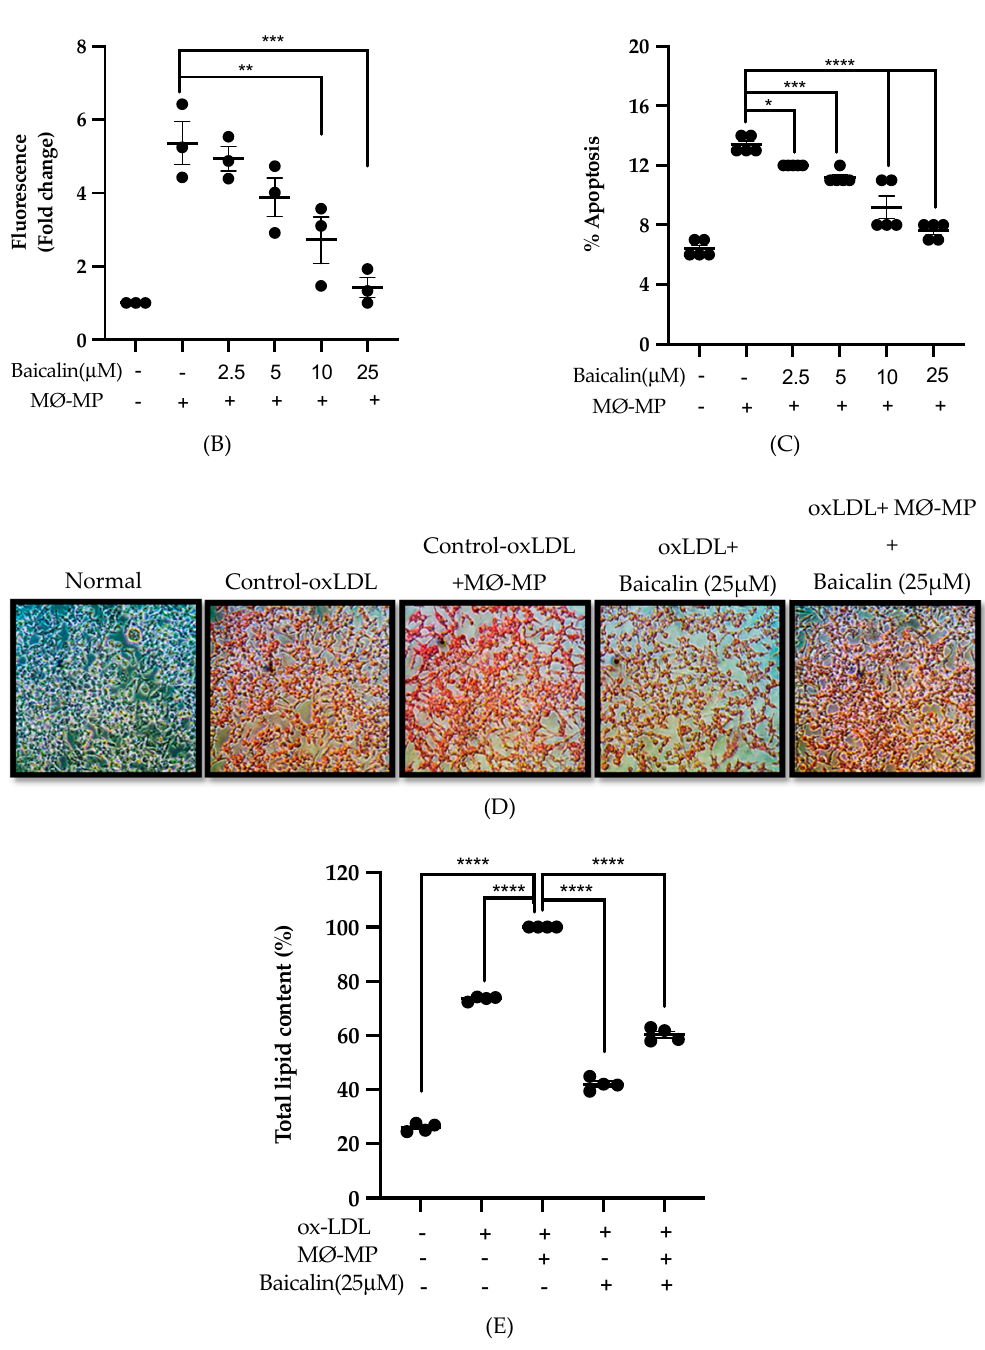
Figure 3. Effect of baicalin on MØ-MP induced reactive oxygen species (ROS) production, apoptosis, and foam cell formation in RAW264.7. ( A ) RAW264.7 cell was treated with or without MØ-MP and a various dose of baicalin for 24 h. DCF-DA was treated to detect the ROS produce by activated RAW264.7 indicated by green fluorescence. Image was taken at 20 × magnification. ( B ) ROS fluorescence intensity was measured at excitation 485 nm and emission 527 nm. ( C ) RAW264.7 cell was treated with or without MØ-MP and a various dose of baicalin for 24 h. Apoptosis assay of RAW264.7 cell measured by Annexin V-FITC staining. ( D ) RAW264.7 cell was treated with or without ox-LDL, MØ-MP and baicalin. The ox-LDL engulfed by cells was measured by Oil Red O staining. ( E ) After ORO, the cell was rinsed with 60% isopropyl alcohol, and the lipid content was quantified. Each value is the mean ± SE of three to five independent experiments and each independent experiment contains five replicates. * p < 0.05, ** p < 0.01, *** p < 0.001, **** p < 0.0001 vs. control (MØ-MP alone). The analysis was performed using one-way ANOVA followed by Dunnett multiple comparison